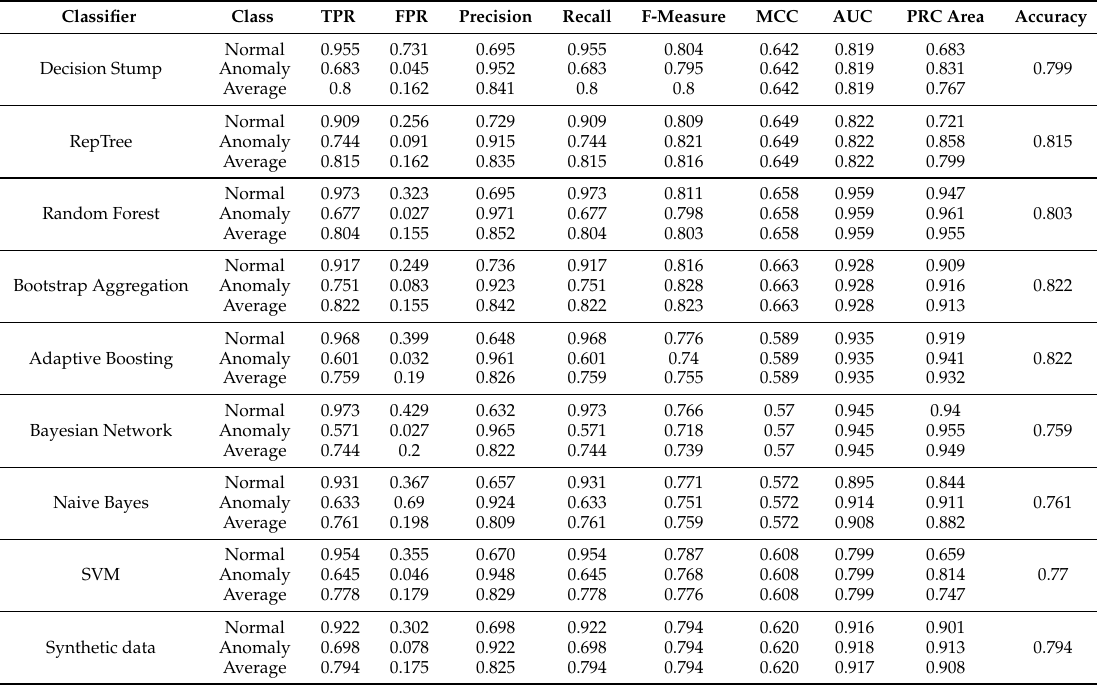
Table 9. Results when analyzing NSL-KDD’99 + .